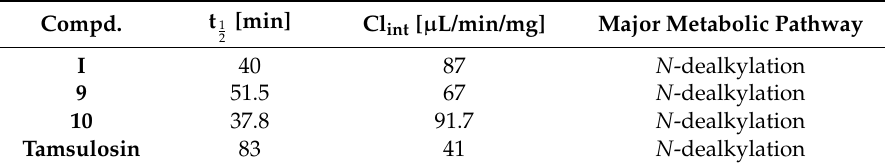
Table 4. Metabolic stability of compounds I , 9 , 10 and reference drug tamsulosin.